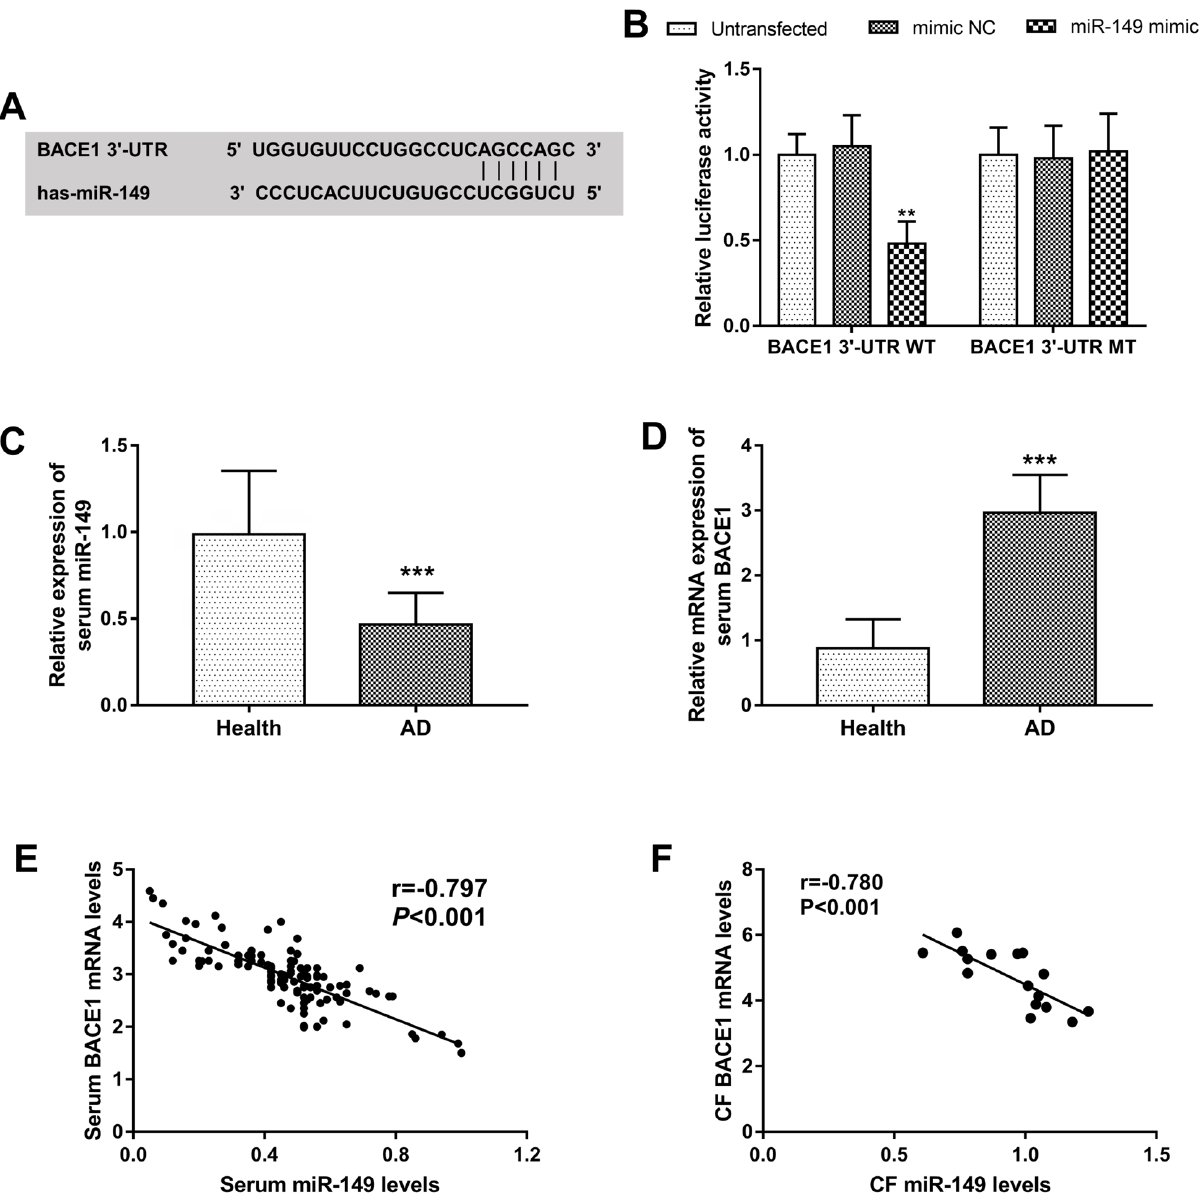
Figure 1 - miR-149 directly binds the 3’-UTR of BACE1. A . The putative binding site of miR-149 at the 3’-UTR of BACE1. B . The luciferase activity results to confirm the interaction between miR-149 and BACE1. C . Serum expression of miR-149 detected by qRT-PCR. D . Serum mRNA expression of BACE1 measured by qRT-PCR. E . A negative correlation between serum miR-149 and BACE1 (r = -0.797, P < 0.001). F . A negative correlation between CF miR-149 and BACE1 (r = -0.780, P < 0.001). CF: cerebrospinal fluid; ** P < 0.01; *** P <